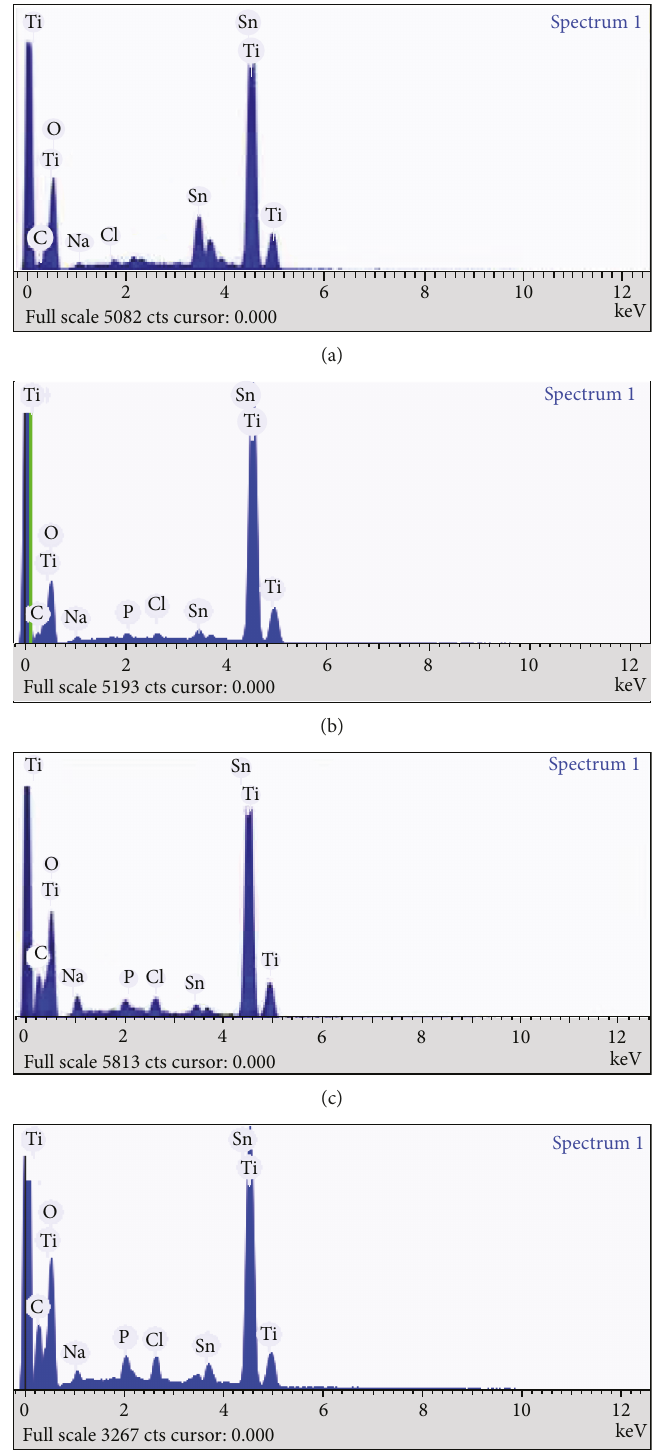
Figure 7: EDS spectra of DSSC in various clathrin percentages: (a) 0%; (b) 25%; (c) 50%; (d)